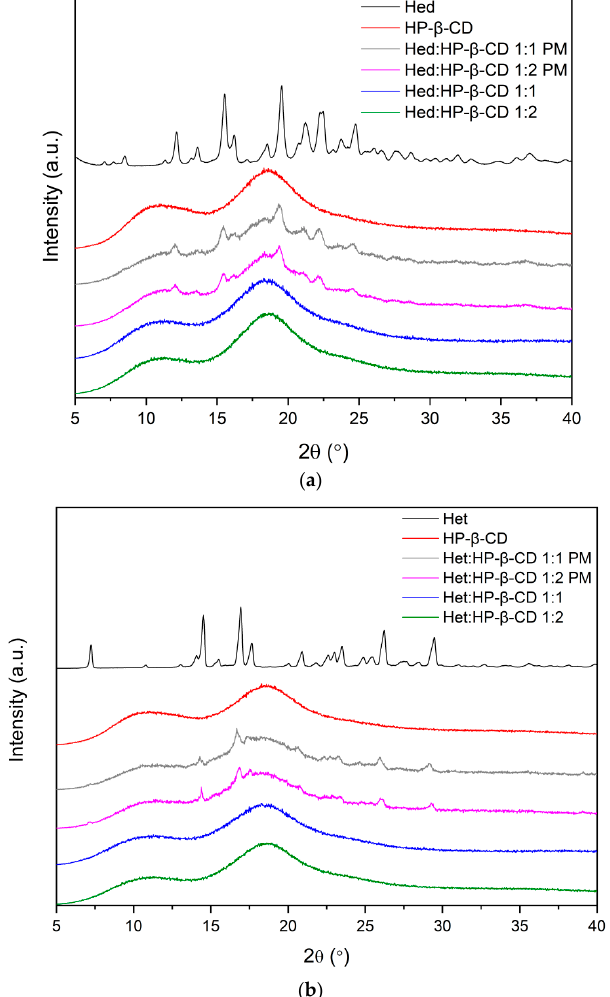
Figure 3. The results of XRPD analysis of Hed ( a ) and Het ( b ) physical mixtures and systems.